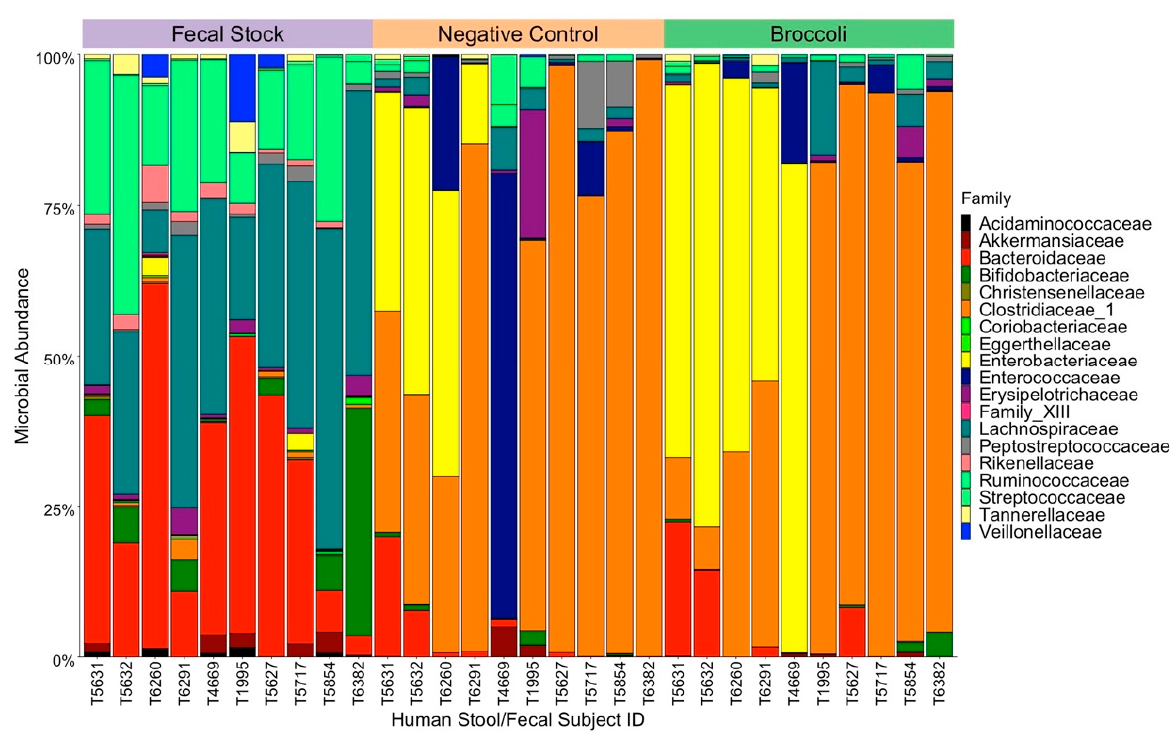
Figure 1. Relative abundance of each family within the pre- and post-incubated fecal cultures ( n = 10). Each color corresponds with a different family and the size of each bar corresponds to relative abundance of that family within each sample. Bars at the top represent treatment groups, pre-incubation fecal stocks (fecal stocks), post-incubation with in vitro digested broccoli (Broc), and post-incubation negative control digest (NC).